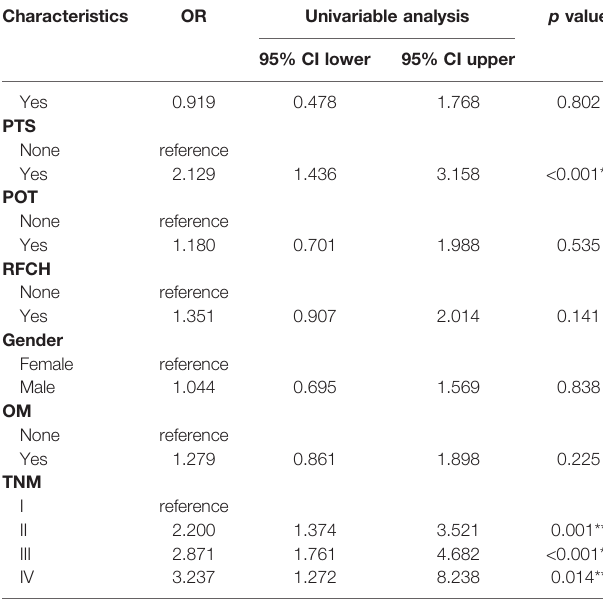
TABLE 2 | Univariable Cox regression model analyses of OS for nomogram. Characteristics